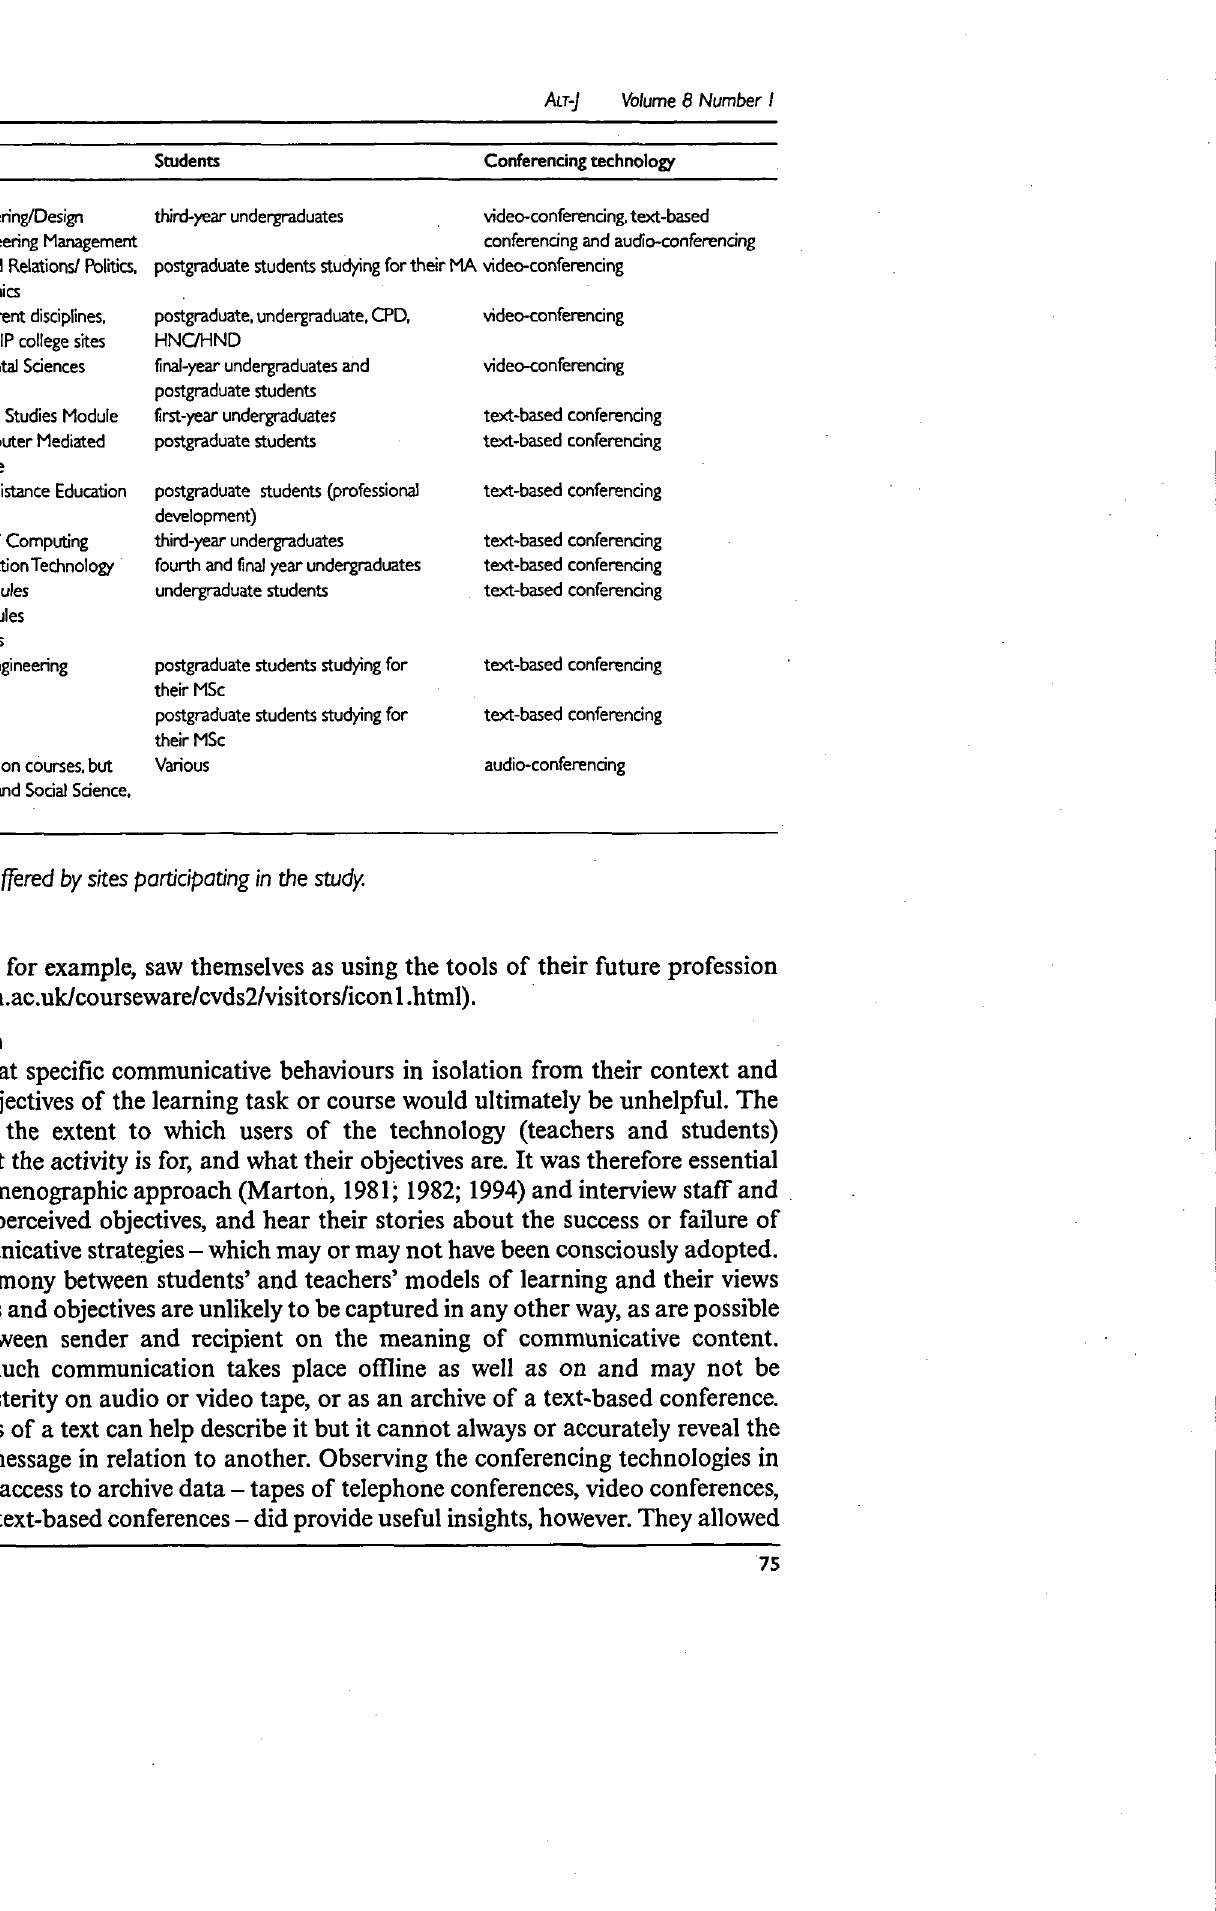
Table I: Courses offered by sites participating in the study.